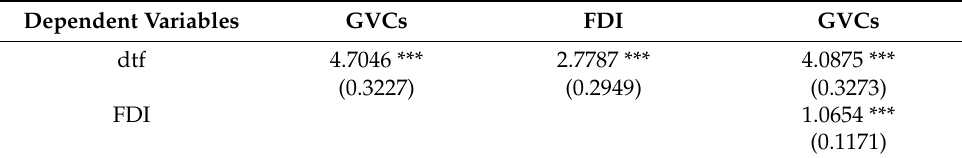
Table 3. Estimate Results of FDI’s Intermediate